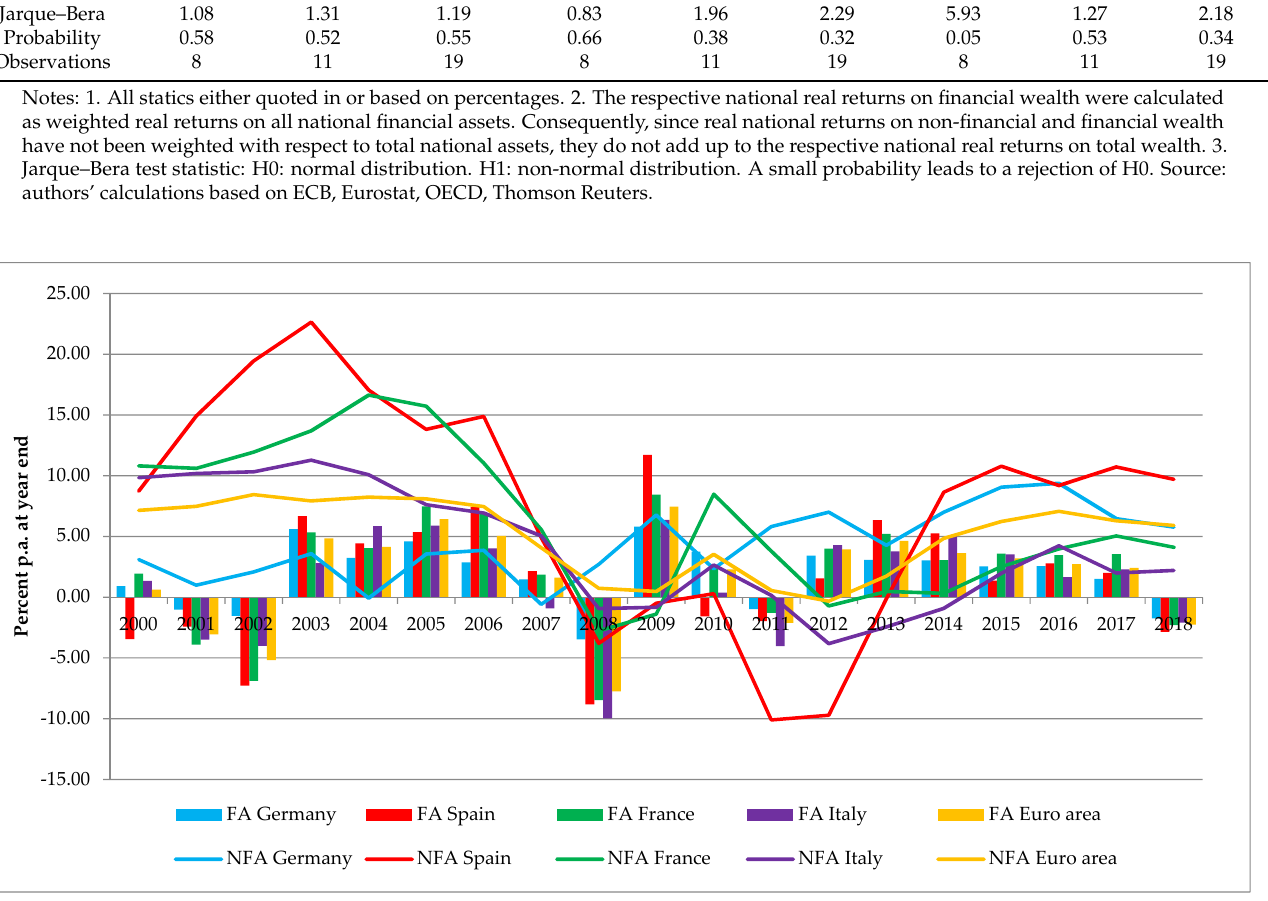
Figure 3. Real returns on euro area households’ non-financial and financial assets. Notes: 1. NFA: non-financial assets; FA: financial assets; 2. The respective national real returns on financial assets were calculated as weighted real returns on all national financial assets. Consequently, since real national returns on non-financial and financial assets have not been weighted in relation to total national assets, they do not add up to the respective national real returns on total assets. Source: authors’ calculation based on ECB, Eurostat, OECD, Thomson Reuters.